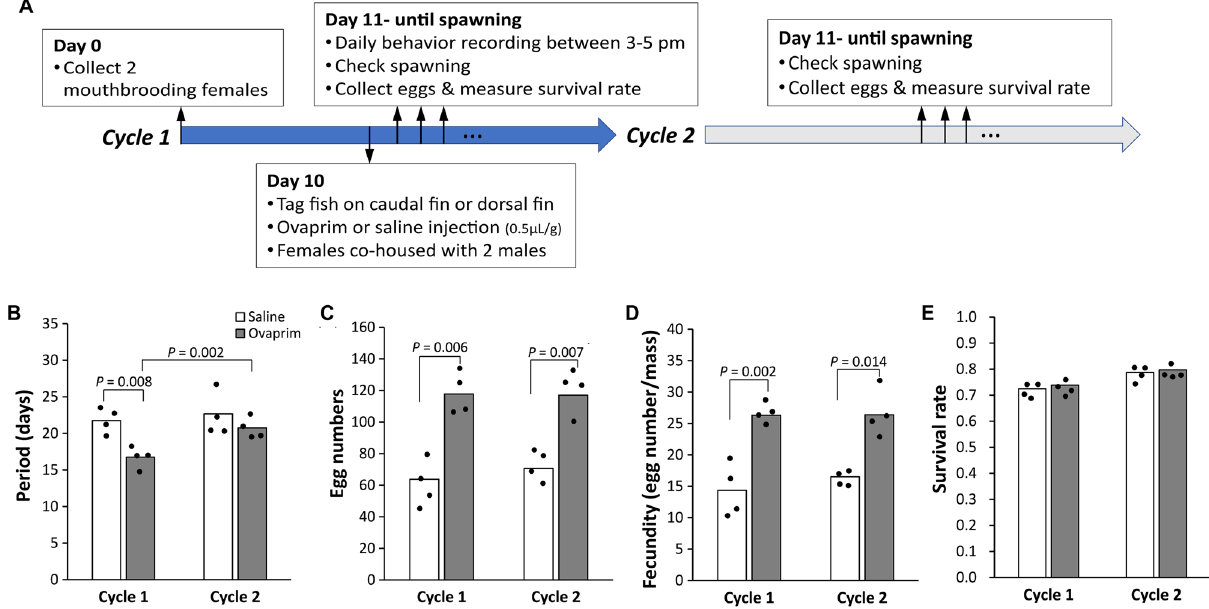
Figure 2. Ovaprim increases fecundity in A. burtoni . ( A ) Workflow for testing Ovaprim effects. We injected Ovaprim (0.5 μL per g of fish) into females 10 days after spawning and monitored for spawning behavior in the following two reproductive cycles. Females were monitored every day until they were observed carrying a brood. ( B ) Ovaprim advanced the reproductive cycle around 5 days, but timing of the following cycle was unchanged. ( C ) Ovaprim increased number of eggs laid compared with saline-injected females, an increase observed in the following reproductive cycle as well. ( D ) Ovaprim increased number of eggs laid, even when controlling for mass of female. ( E ) Ovaprim did not affect the overall survival rates of the embryos. Two-tailed Mann–Whitney U test was used to compare gene editing parameters. The Tyrosinase ( Tyr1 ) gene has been shown to be necessary in medaka, zebrafish, and anole lizards for producing eumelanin from tyrosine 24,25,29 . We synthesized gRNAs that target the intramelano- somal, common central domain of Tyr1 , a sequence identical at the nucleotide level across cichlids (Fig. 5A). We injected these along with Cas9 protein into single-cell embryos (Fig. 3H). We monitor embryo survival for approximately 10 days post-fertilization (dpf) to identify issues that contribute to low survival rates (Fig. 3J). By 3 days post-fertilization, uninjected embryos developed black, ramified melanocytes. In contrast, we found that ~ 50% of injected embryos exhibited a reduction in the number of melanocytes (Fig. 4A), suggesting that Tyr1 gene function is necessary for eumelanin synthesis in cichlids. We were surprised to find ramified, fluorescent cells scattered across the surface of Tyr1 CRISPR-injected cichlid embryos, but not in control embryos (Fig. 4D). These cells also appeared at 2–3 dpf, and their number was inversely proportional to the number of black melanocytes. This suggests that in the absence of functional Tyr1, melanocytes accumulated a fluorescent metabolite derived from tyrosine. Further, we speculate this is not tyrosine itself due to its green, rather than blue, fluorescence emission 30 . As CRISPR-injected embryos are mosaics of cells bearing different mutations or unmodified alleles, the conversion of melanocytes from black (Tyr-positive) to fluorescent (Tyr-mutant) permits a quantification of gene editing efficiency. To test whether this metric reflected genomic mutation rate, we quantified the ratio of melanocyte conversion and obtained genomic DNA from embryos to assess indel rates. We adapted a PCR amplification approach 31 to evaluate muta- tion induction in injected embryos using PCR size analysis. This approach quantitatively and rapidly detects size polymorphisms that result from indel mutations (Fig. 4C), the sequence changes most likely to affect gene function. We found a positive correlation between indel rate and black-to-fluorescent melanocyte conversion (Fig. 4D). Notably, melanocytes can be rapidly counted, and can be performed at an early stage. It thus will enable a rapid exploration of CRISPR parameters, and to troubleshoot problematic reagents. Previous work using CRISPR/Cas to generate mutant cichlids utilized single guide RNAs (sgRNAs) that incorporate both crRNA and tracrRNA 32–34 . Recent work shows that using separate crRNA and tracrRNA as is utilized naturally in S. pyogenes (dual-guide RNA system; dgRNA) drives more efficient gene editing in zebrafish than does sgRNA 35 . We synthesized sgRNA and dgRNA (Supplementary Fig. 1A) that target the same Tyr1 site to directly test whether this finding holds true in cichlids. We find high gene-editing rates at the Tyr1 locus with either sgRNA or dgRNA systems (Supplementary Fig. 1B). Homozygous Tyr1 mutant cichlids enable in situ imaging. Tyr1 CRISPR-injected fish remain mosaic animals through adulthood (Fig. 4B). We crossed injected fish to wild-types and screened offspring using Tyr1 locus-specific fragment analysis. We identified a fish heterozygous for a 20 bp deletion at Tyr1 ( Tyr1 d20/+ ) (Fig. 5C). An intercross of Tyr1 d20/+ animals yielded 1/4 of offspring devoid of eumelanin from 2 dpf through